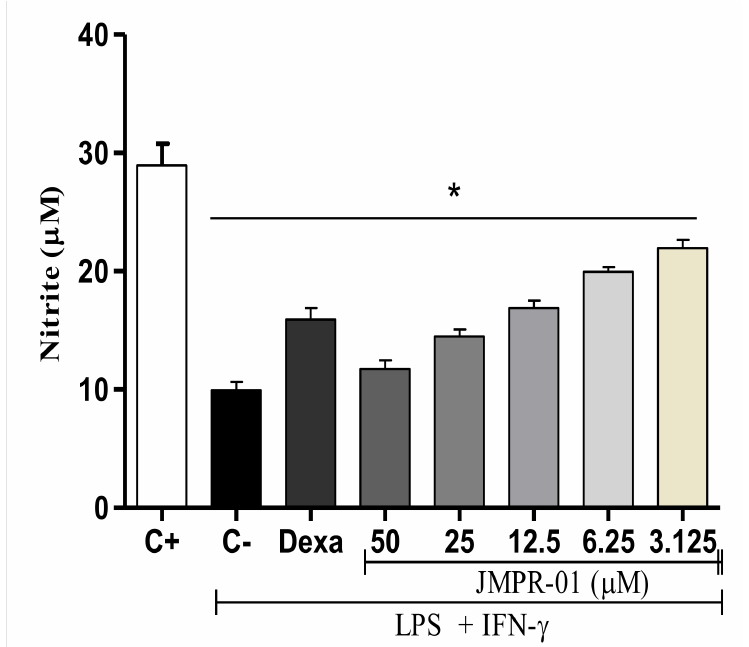
Figure 2. Modulation of nitric oxide (NO) (nitrite in µ M) in activated J774 macrophage cells treated with JMPR-01 (3.125-50 µ M) by the Griess method. Data representes mean standard error of the mean ± SEMs; n = 6 determinations per group. * Significantly different from the vehicle treated cul- tures stimulated with LPS + IFN- γ ( p < 0.05). ANOVA followed by Tukey’s multiple comparison